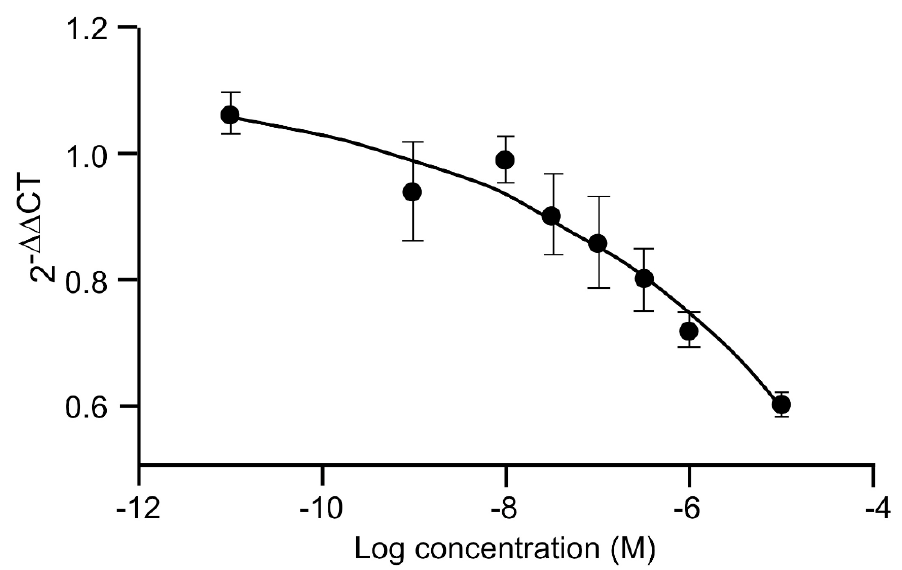
Figure 3. Dose-dependent inhibition of myostatin gene expression in C2C12 cells by 20E. C2C12 mouse myoblasts were differentiated for 6 days into myotubes. They were then treated for 6 h with concentrat ions of 20E ranging from 0.001 to 10 μM. Myostatin gene expression was detected by qRT-PCR. Results are shown as means ± standard error of the mean (SEM) ([103]).